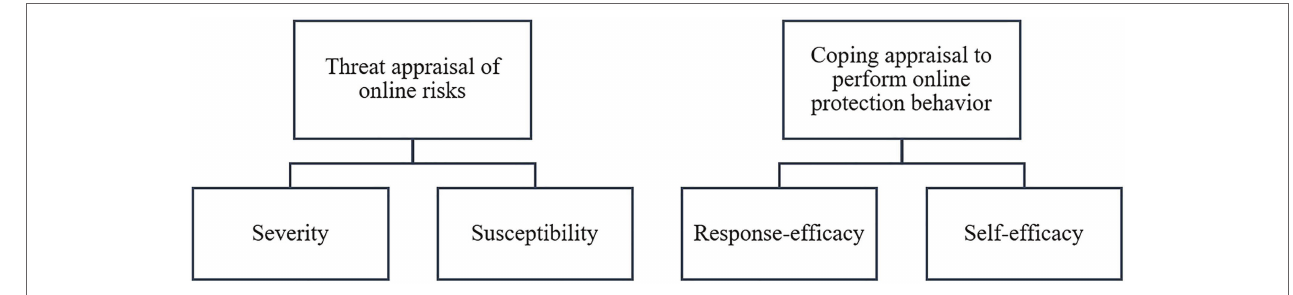
FIGURE 2 | Protection motivation as a key predictor of parental internet